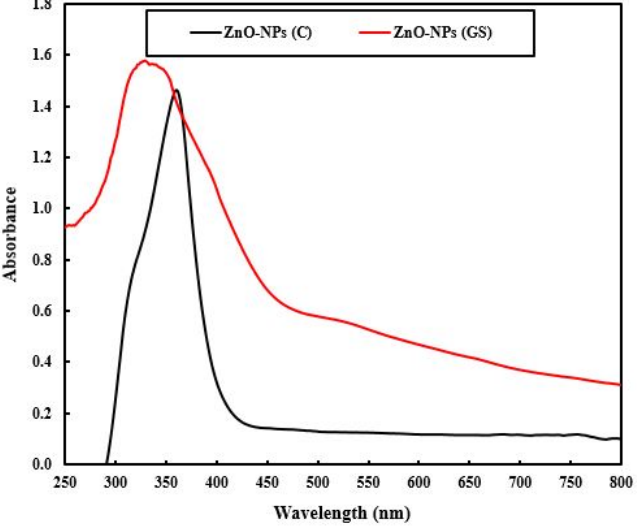
Figure 5. UV–vis diffuse reflectance spectroscopy (DRS) spectra of commercial (C) and green synthesized (GS) ZnO-NPs.